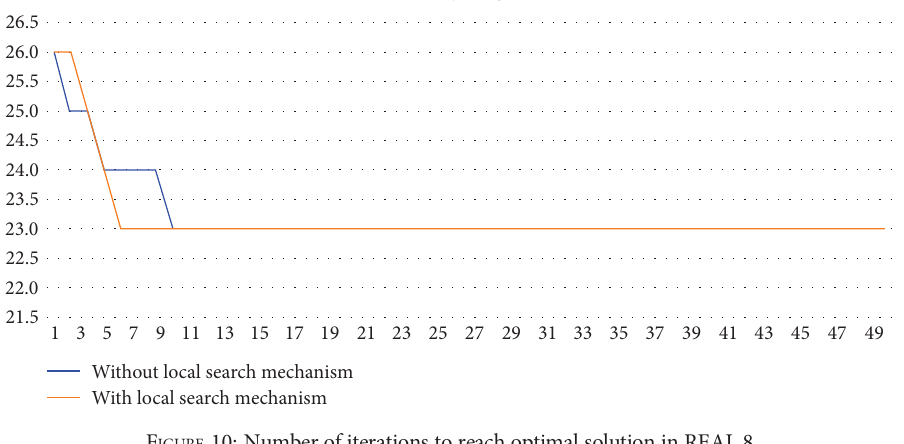
F IGURE 10: Number of iterations to reach optimal solution in REAL